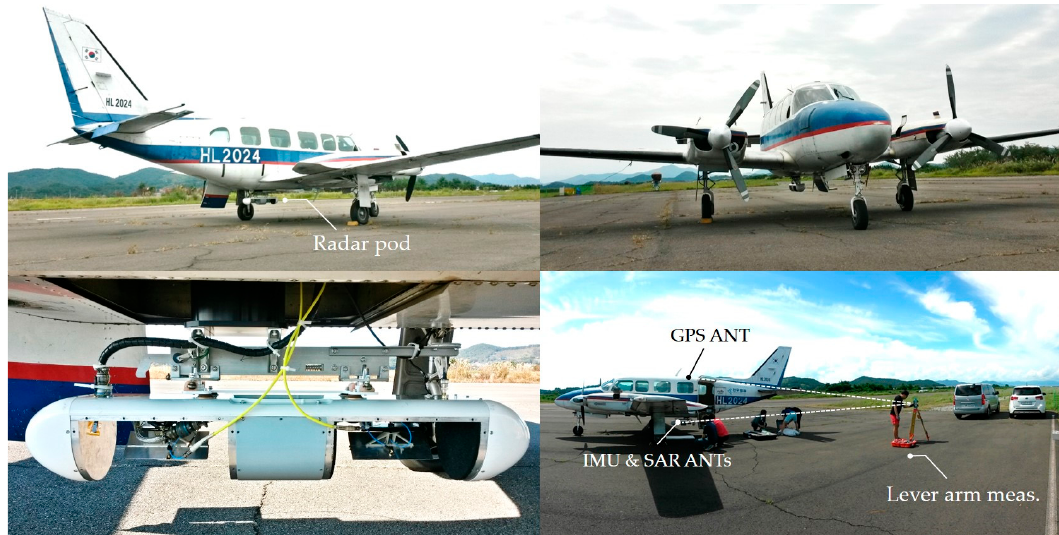
Figure 8. Overview of the airborne FMCW SAR system: radar pod was mounted at the bottom of the fuselage of PIPER PA31-350 and Tx/Rx antennas of NanoSAR-B were installed for left-looking as a default setup. The lever arm was measured with a total station, then its spatial coordinate was entered into NanoSAR-B as a system parameter and used for SAR image focusing.